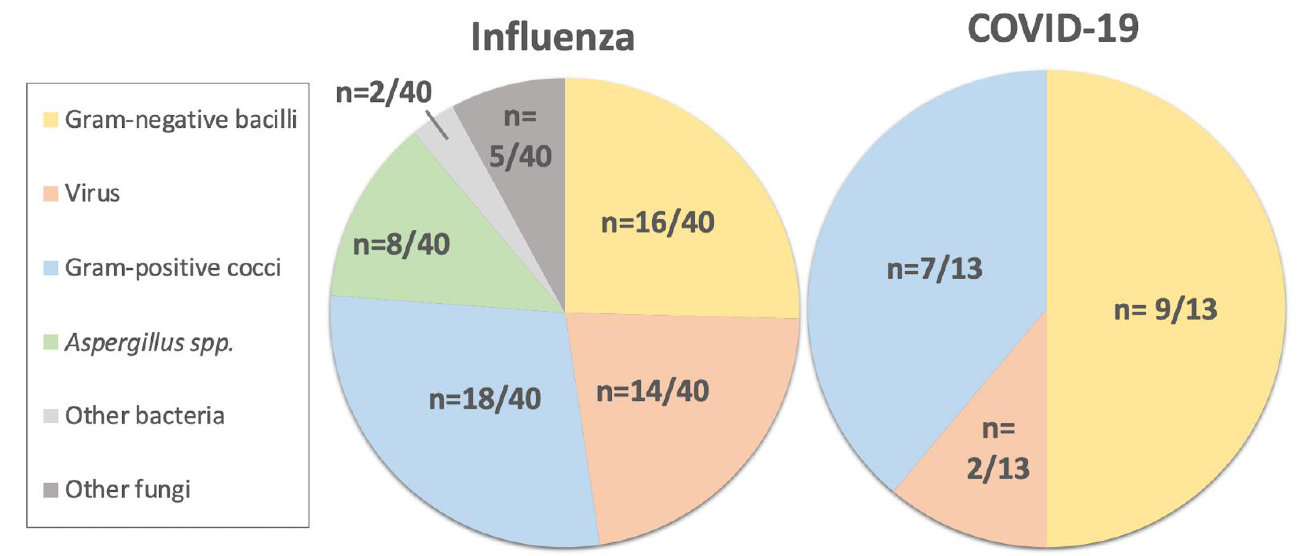
Figure 1. Co-infections in COVID-19 patients versus Influenza ICU patients. Table 3 provides the results of the univariate logistic regression model exploring the risk factors for co-infections. Table S1 provides the frequencies of each variable among the co-infected and non-co-infected patients in both cohorts. Influenza infection and im- munosuppression (IS) therapy were identified as risk factors for co-infections upon ICU admission. Each variable for which the univariate odds ratio (OR) yielded a p -value ≤ 0.1 was then included in a multivariable logistic regression model. Only IS therapy was identi- fied as an independent risk factor for co-infections among both the COVID-19 and Influenza